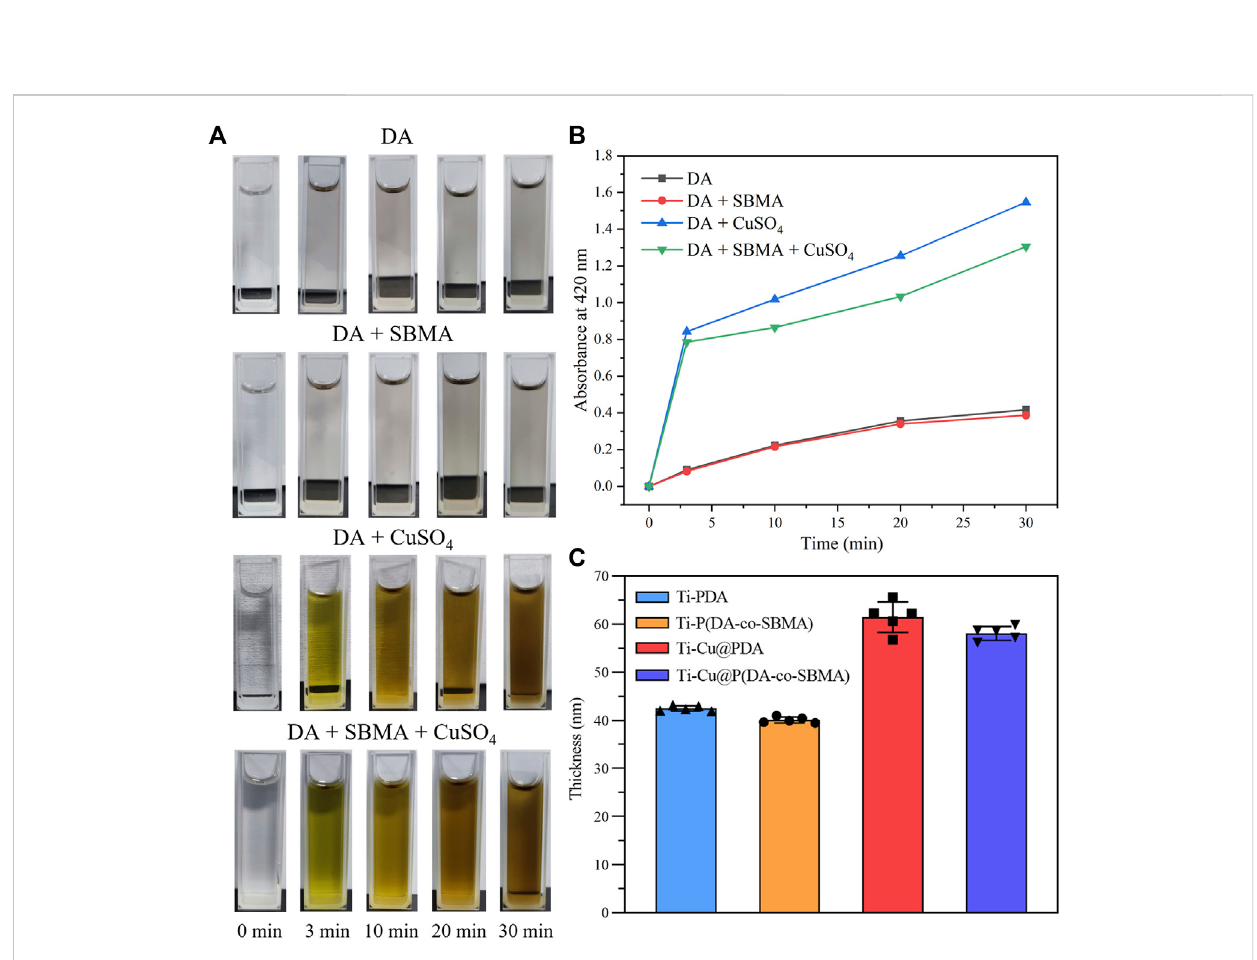
FIGURE 2 (A) Photographs of different solutions at different times. (B) UV – vis absorbance of different solutions at 420 nm with time. (C) The thickness of different coatings.